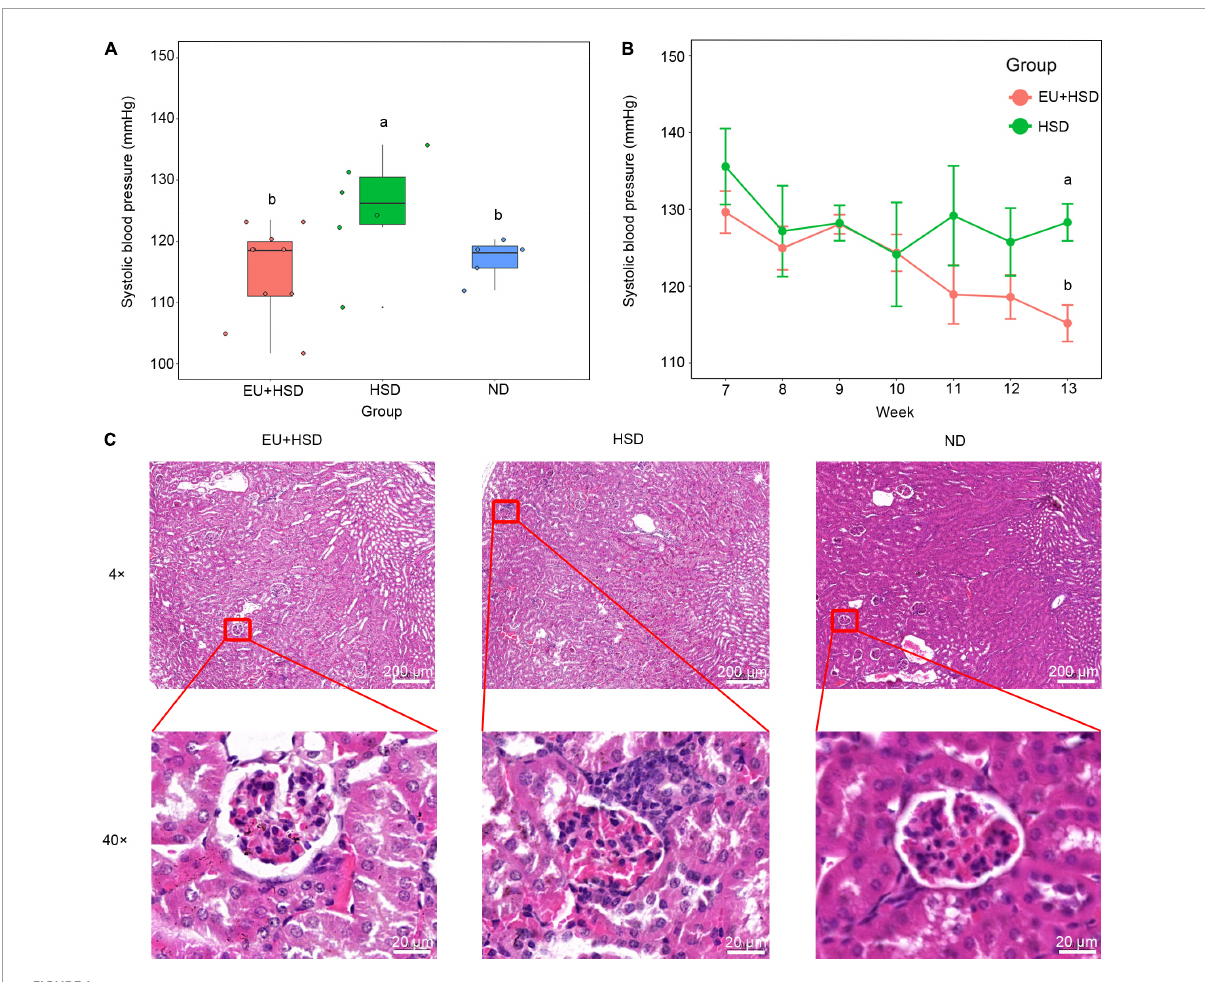
FIGURE1 Anti-hypertensive effect of EU. Blood pressure (A) in the EU + HSD, HSD, and ND groups in week 13 and (B) in the EU + HSD and HSD groups from weeks 7 to 13. (C) HE staining of kidney tissues in the EU + HSD, HSD, and ND groups.